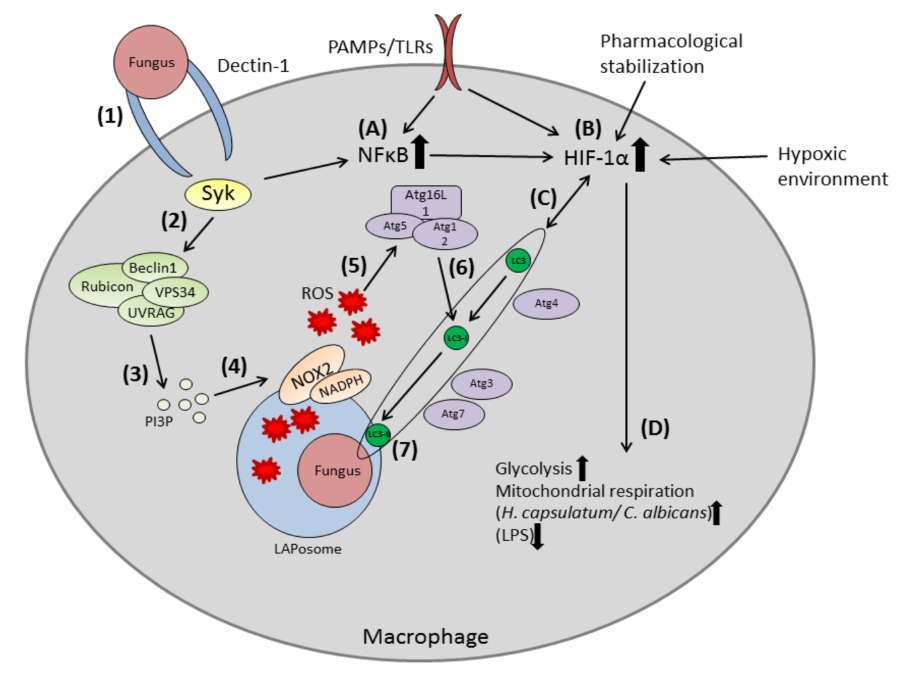
Figure 1. Overview of the LAP pathway in macrophages during fungal infection. ( 1 ) Pattern recognition receptors (PPRs) on macrophages (Dectin1) recognize fungal pathogen and initiates phagocytosis. ( 2 ) The Dectin1 / Syk kinase complex recruits the PI3K-complex to the LAPosome. ( 3 ) The PI3K-complex generates PI3P, which localizes to the LAPosome. ( 4 ) PI3K, together with Rubicon, stabilizes the NOX2-complex, followed by assembly of the NOX2 NADPH oxidase complex. ( 5 ) ROS production leads to recruitment of the LC3-conjugation complex (Atg5 / Atg12 / Atg16L1). ( 6 ) Atg3, Atg4 and Atg7 form LC3-II from LC3. ( 7 ) Lipidation of LC3-II to the LAPosome and maturation of the LAPosome. Maturation is followed by fusion with the lysosome and killing of fungal pathogens. ( A ) The Syk-pathway simultaneously increases NF κ B ( B ) HIF-1 α is stabilized by increased NF κ B, hypoxia or pharmacological treatment. ( C ) HIF-1 α is inversely regulated to LC3-II. ( D ) HIF-1 α upregulates glycolysis and mitochondrial respiration during infection with C. albicans or H. capsulatum